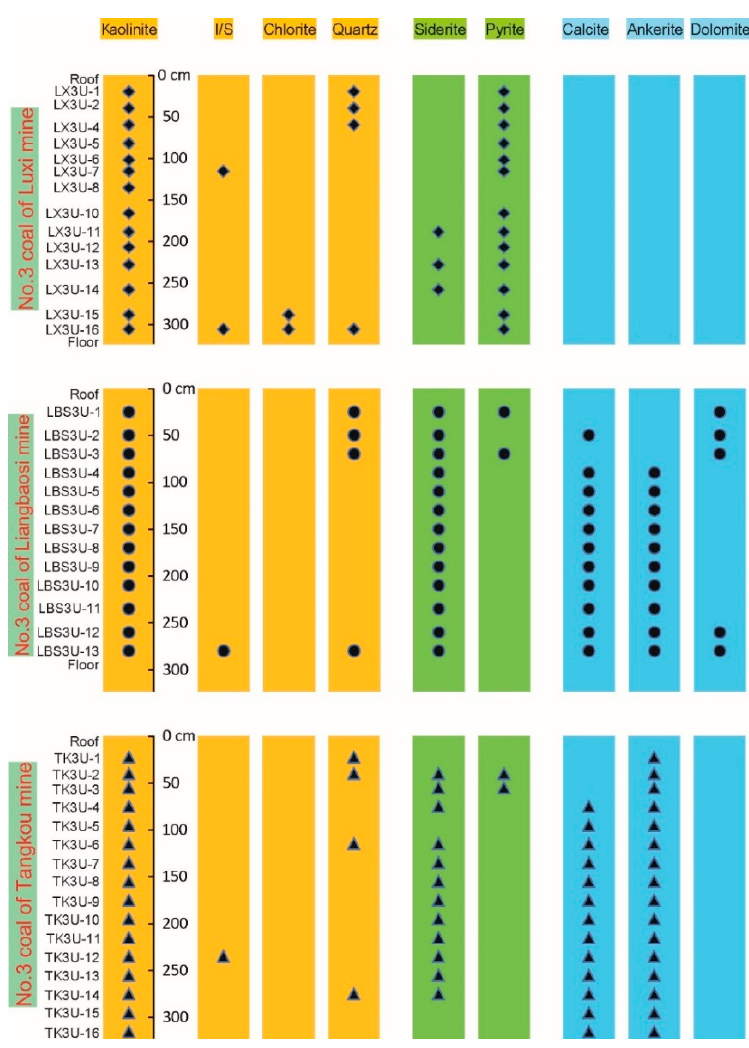
Figure 6. Mineral distributions through the three Upper No.3 coal sections. I/S, mixed layer illite/smectite.